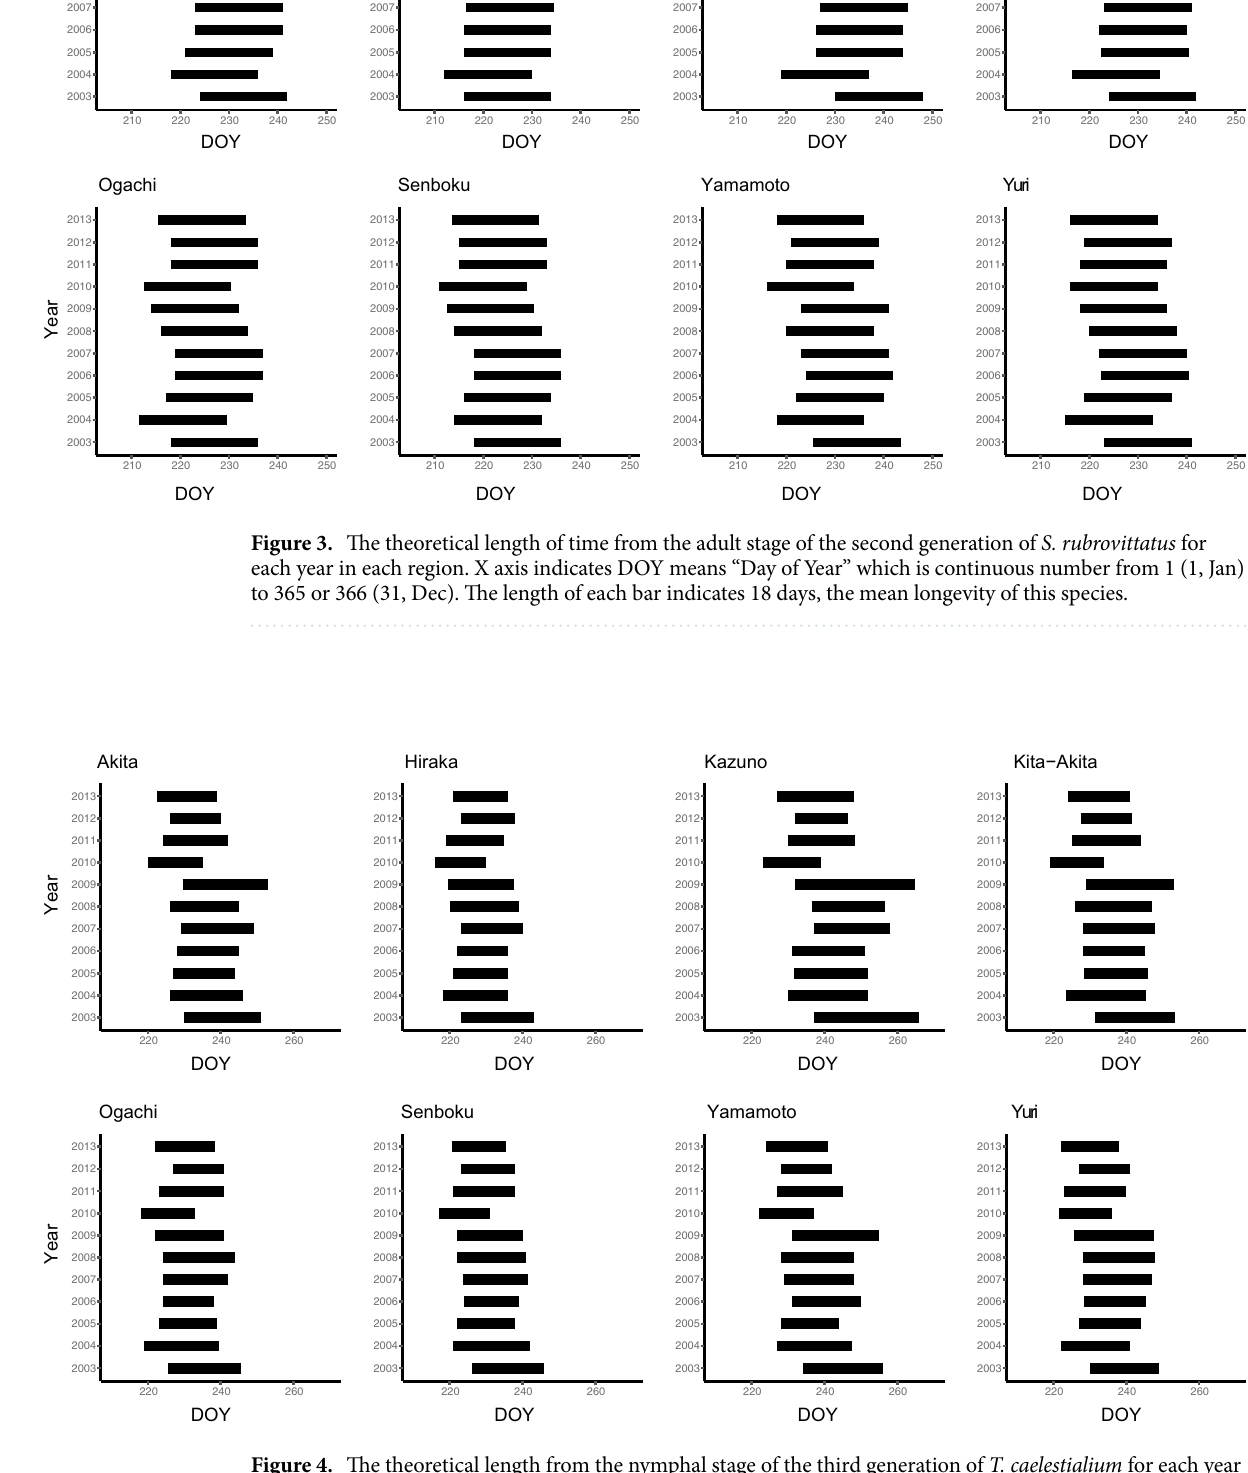
Figure 4. The theoretical length from the nymphal stage of the third generation of T. caelestialium for each year in each region. X axis indicates DOY means “Day of Year” which is continuous number from 1 (1, Jan) to 365 or 366 (31, Dec). The length of each bar indicates the period from the median egg hatching date across regions to the median maturation date across the region in the